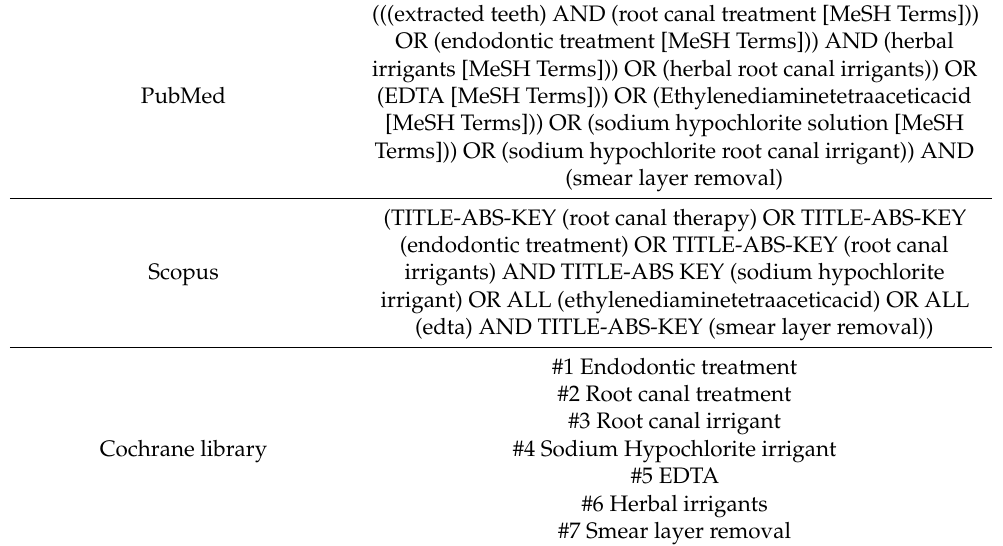
Table 1. Search strategy.